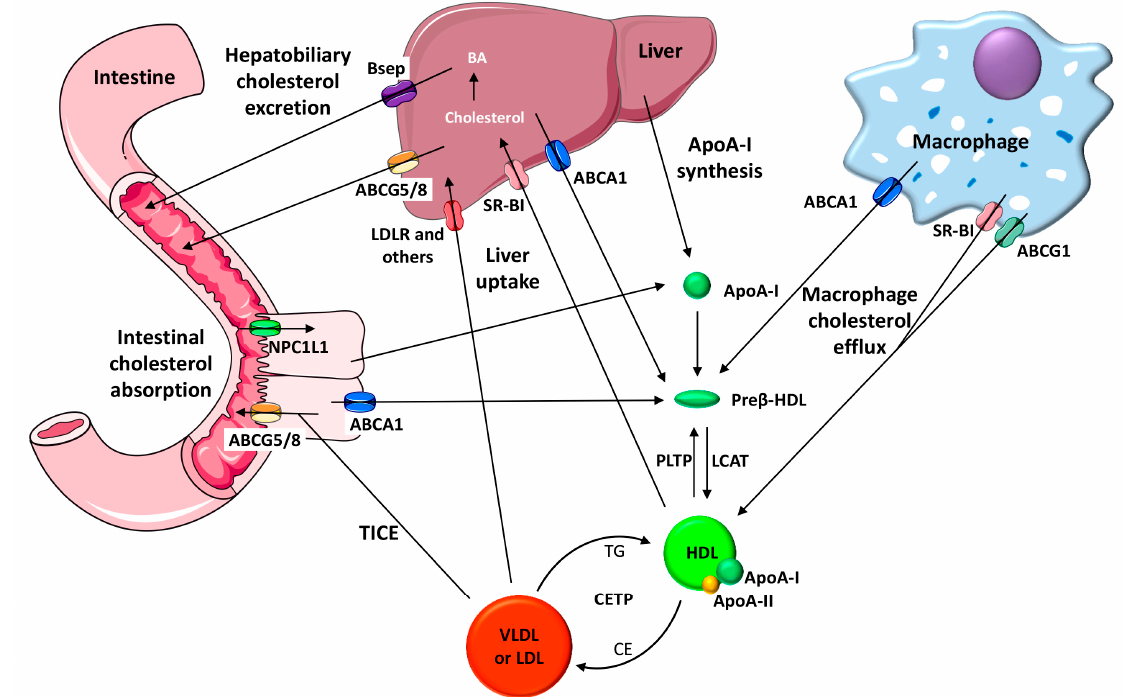
Figure 1. A schematic diagram of macrophage-to-feces reverses cholesterol transport pathways. ApoA-I is synthesized by the liver and small intestine, and it acquires phospholipids to become partially lipidated pre β -high-density lipoprotein (HDL) particles at its nascent stage. Pre β -HDL particles acquire free cholesterol from macrophages via the adenosine triphosphate-binding cassette (ABC) A1 transporter. The free cholesterol is converted into cholesteryl ester within the HDL particle by the action of Lecithin: cholesterol acyltransferase (LCAT), thereby resulting in mature HDL. ApoA-I is the major HDL protein and activates LCAT, whereas apoA-II, the second HDL protein, displaces apoA-I from the HDL particles. Both the macrophage scavenger receptor class B type I (SR-BI) and ABCG1 facilitate the cholesterol efflux process from macrophages to mature HDL. The phospholipid transfer protein (PLTP) promotes the transfer of phospholipids and free cholesterol from triglyceride-rich lipoproteins into HDL, producing a remodeling process where pre β -HDL particles can be generated. HDL cholesterol esters can be transferred to very low density lipoprotein (VLDL) or low-density lipoprotein (LDL) by the cholesteryl ester transfer protein (CETP) and be returned to the liver through the low-density lipoprotein receptor (LDLR) or other LDL and VLDL receptors. Another function of the liver is to take up HDL-associated cholesterol selectively via SR-BI. Cholesterol can be secreted into bile as unesterified cholesterol via the ABCG5/G8 heterodimer or used to synthesize bile acids (BA). The bile salt export pump (BSEP) is involved in the bile acid transport to bile. Niemann-Pick C1-like 1 (NPC1L1) is of crucial importance for absorbing macrophage-derived cholesterol in the small intestine. Cholesterol may also be excreted back to the lumen by the intestinal ABCG5/G8 heterodimer. The transintestinal cholesterol export (TICE) route promotes the flow of cholesterol from plasma to enterocytes and the intestinal